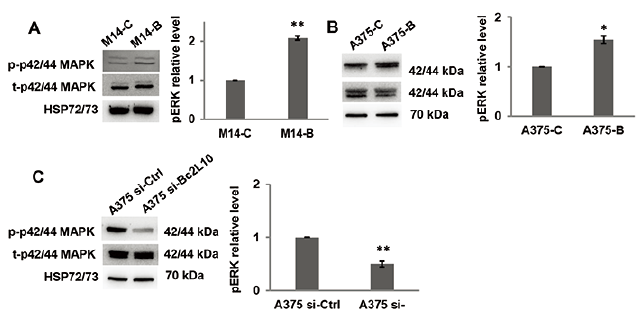
Figure 3. Bcl2L10 promotes ERK phosphorylation. (A–C) Western blot analysis of total (t) and phosphorylated (p) p44/42 MAPK (ERK1/2) and relative densitometric analysis of pERK in (A) M14-B and M14-C cells, (B) A375-C and A375-B cells, and (C) A375 si-Bcl2L10 and A375 si-Ctrl cells. Reported images are representative of three independent experiments with similar results. HSP72/73 was employed to check equal loading and transfer. For densitometric analysis, the relative levels of proteins were expressed in the histograms as fold changes respected to relative control after normalization. Data were expressed as mean ± standard deviation. Statistical analysis was performed applying unpaired two-tailed student’s t test with Welch’s correction. * P < 0.05; ** P < 0.01